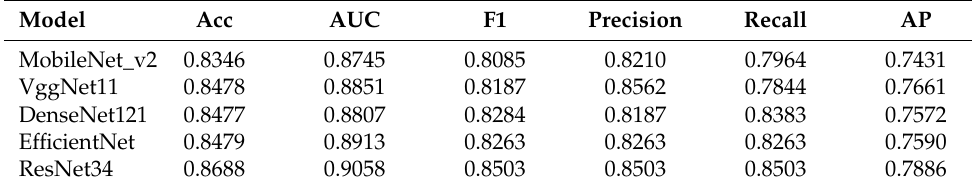
Table 2. The performance results of different backbone models on PET